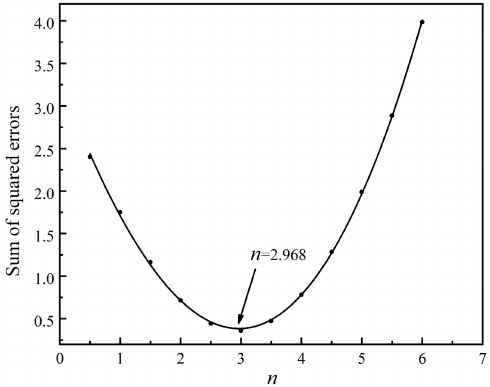
Figure 6. Fitted curve between the sum of squared error and